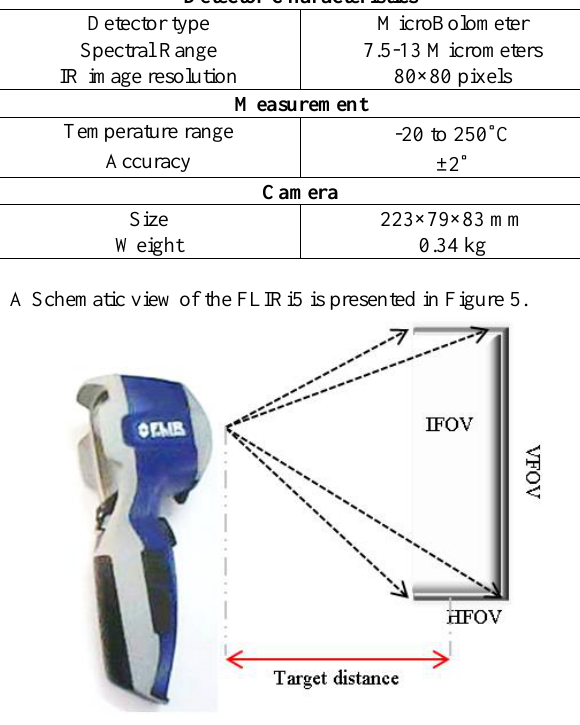
Figure 5: FLIRi5 sensor